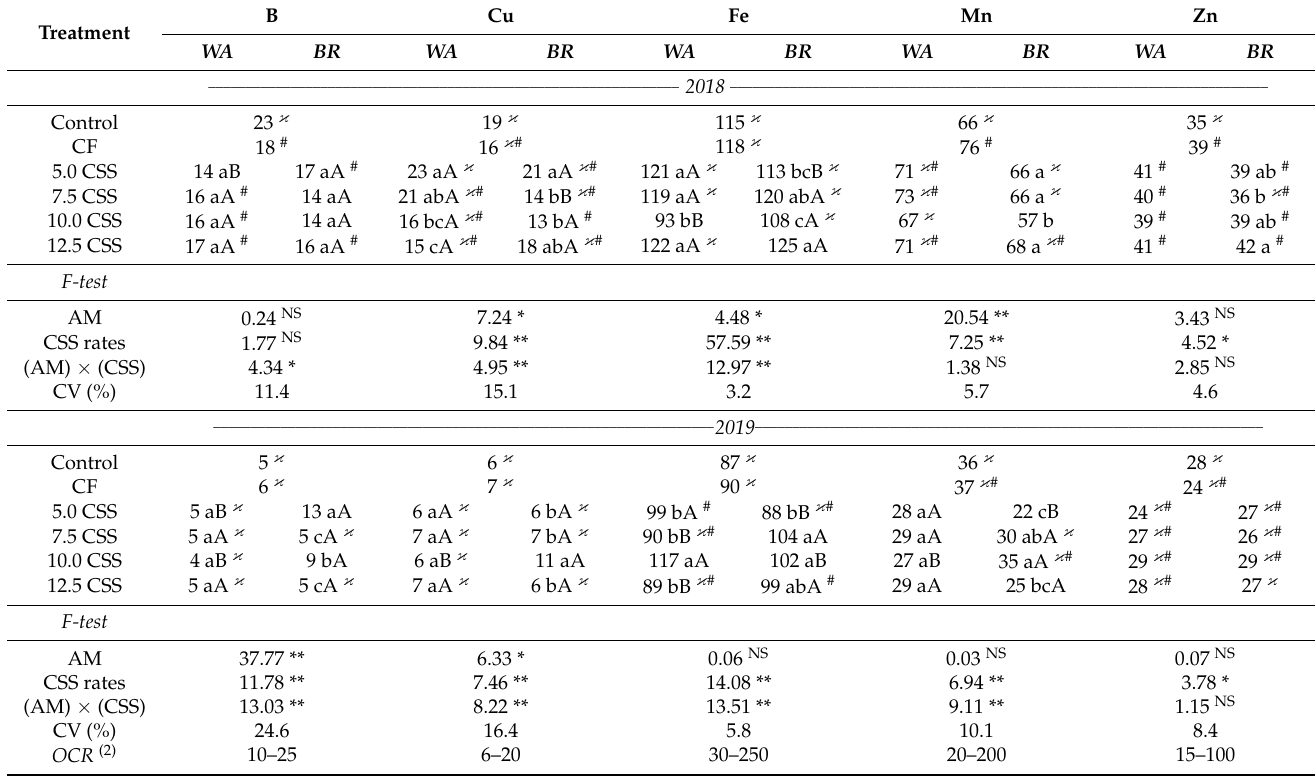
Table 2. Boron, Cu, Fe, Mn, and Zn concentration (mg dm − 3 ) in leaves (1)